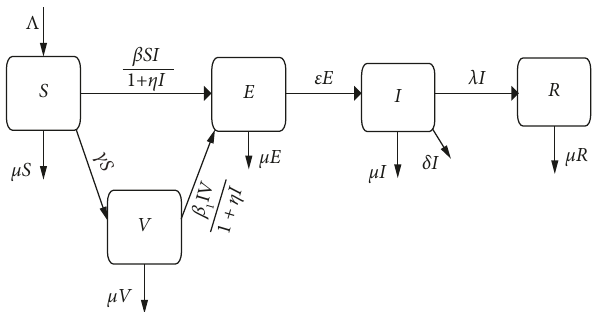
Figure 1: A schematic flow diagram of the COVID-19 dynamics model with